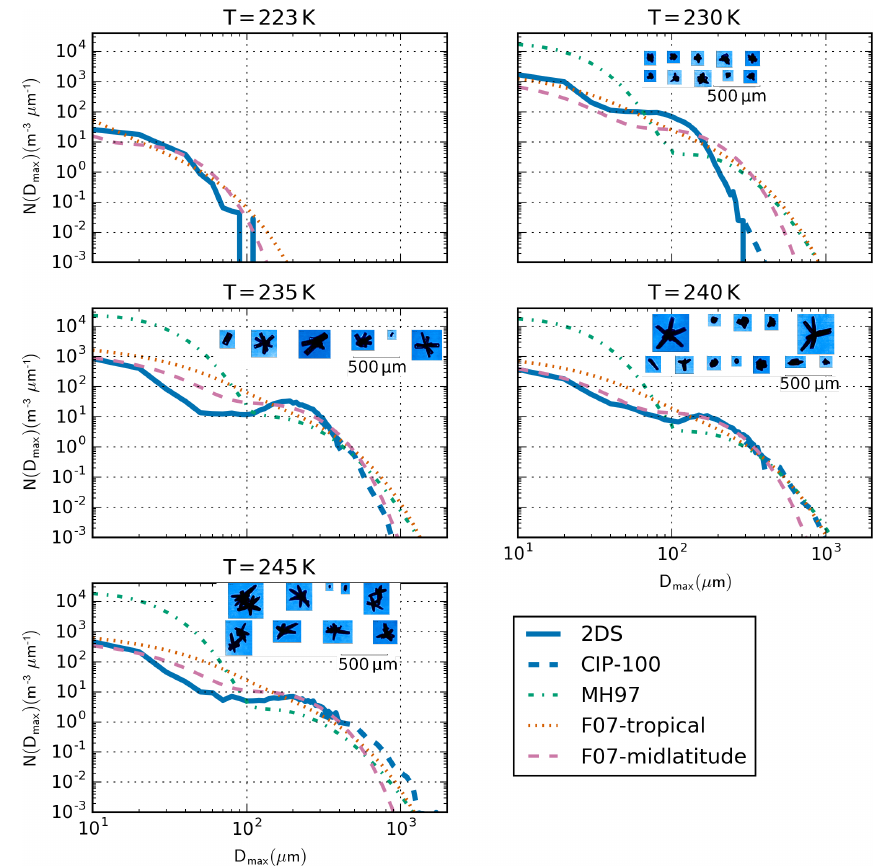
Figure 3. Particle size distributions from in situ runs during flight B895, with example CPI images showing ice crystal